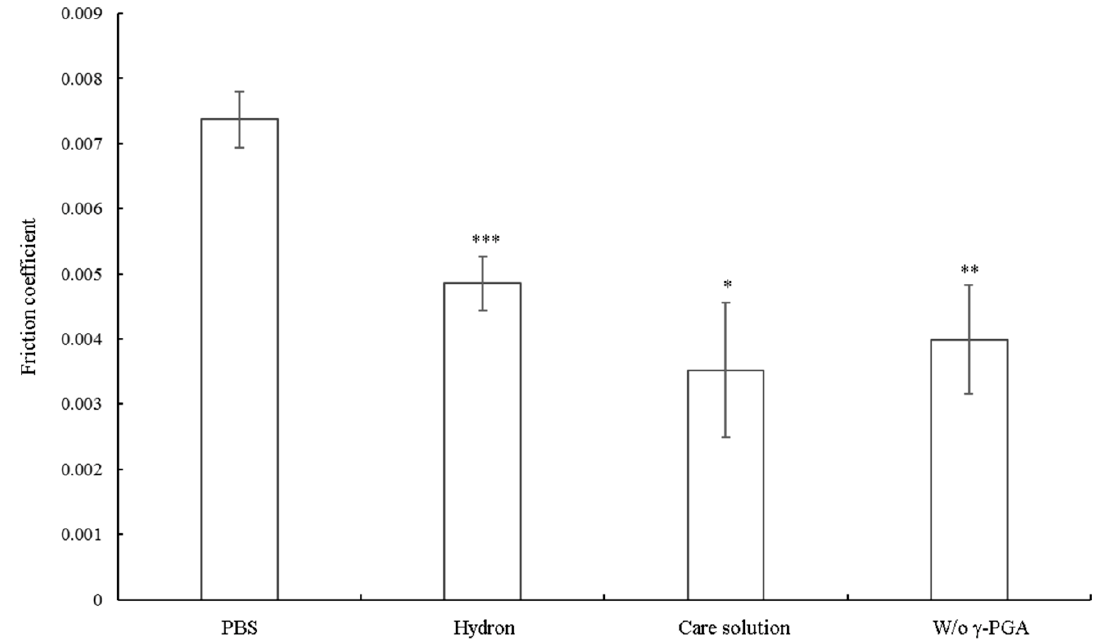
Figure 3. The coefficient of friction of the multipurpose contact lens care solution or the care solution without γ -PGA. When contact lenses were rubbed against the glass in the commercial care solution Hydron, the multipurpose care solution, or the solution without γ -PGA, the coefficients of friction were all lower than that of PBS. The friction coefficient increased in the absence of γ -PGA compared with the solution containing γ -PGA. When comparing with the friction coefficient of PBS, * p < 0.05, ** p < 0.01, and *** p < 0.001.